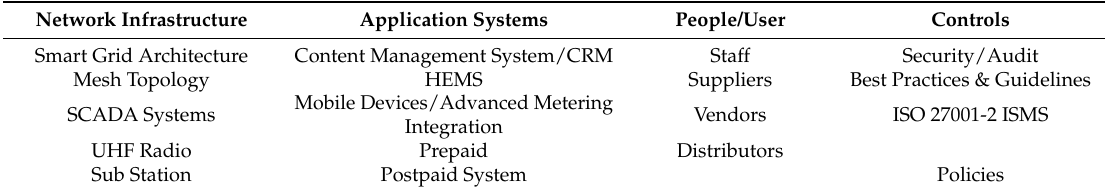
Table 1. Electricity Corporation of Ghana (ECG) core businesses